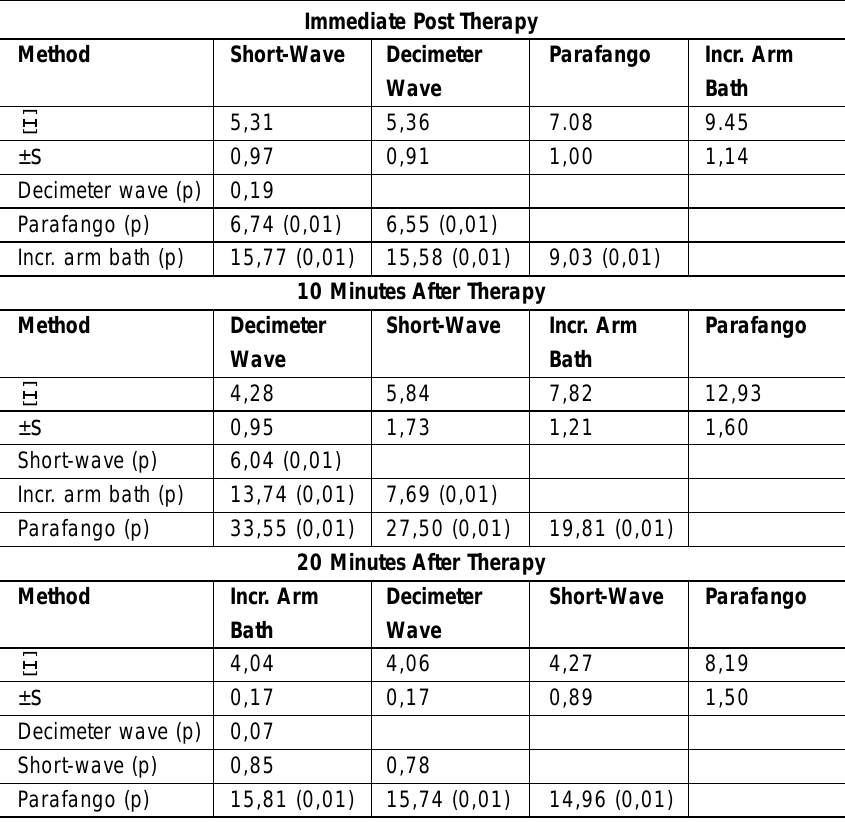
Table 3: Mean value comparisons (Newman-Keuls-test) of the consensual reaction of the circulation at defined control intervals within the patients’